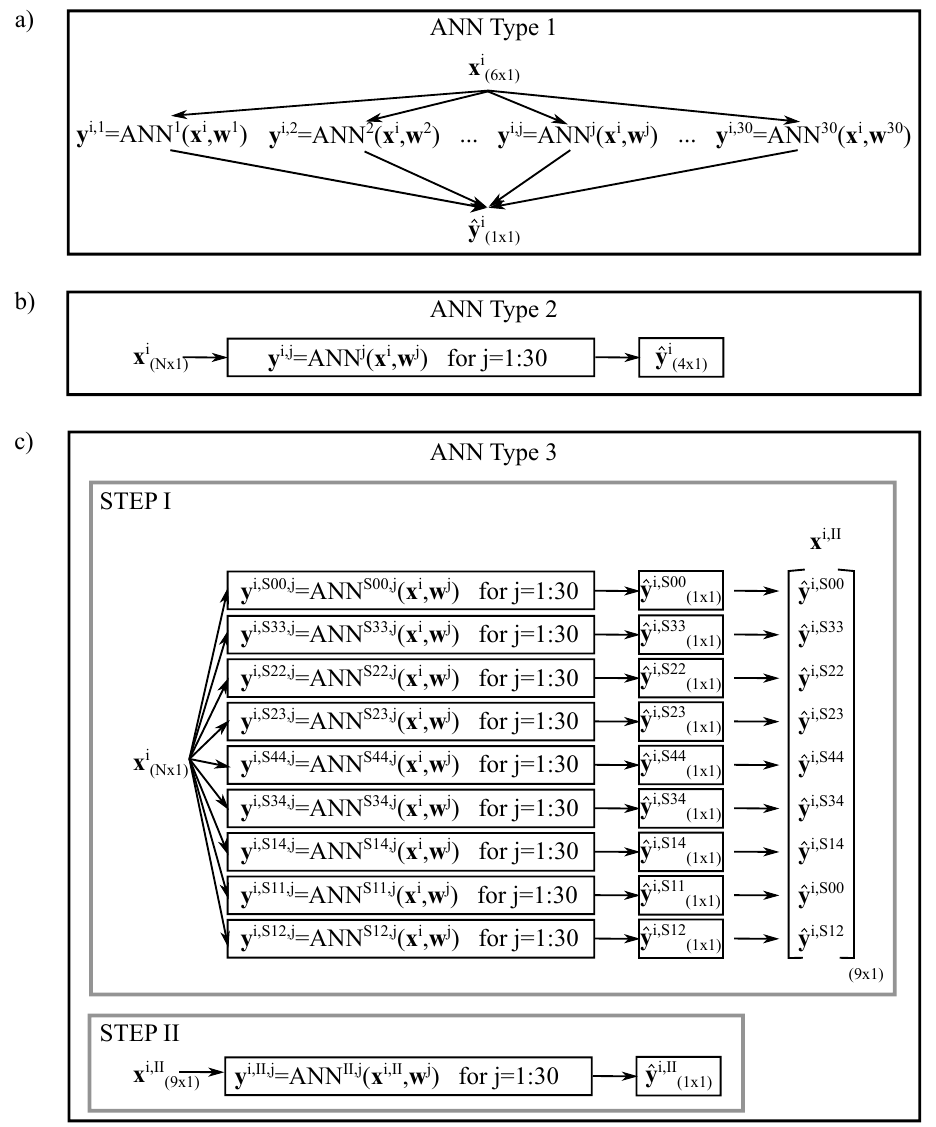
Figure 4. ( a , b ) One- and ( c ) two-step procedure for anomaly detection using